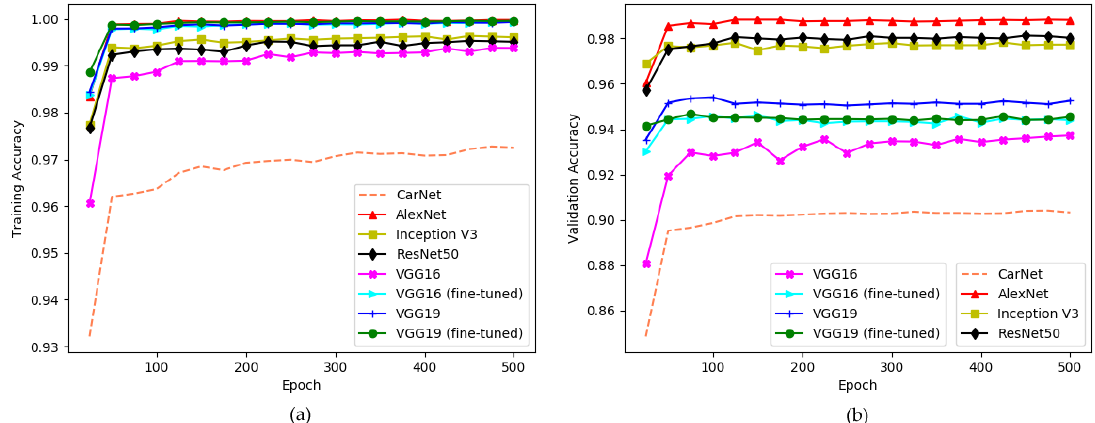
Figure 12. Experiment on PKLot [4] dataset. Comparison of our model with respect to other models.